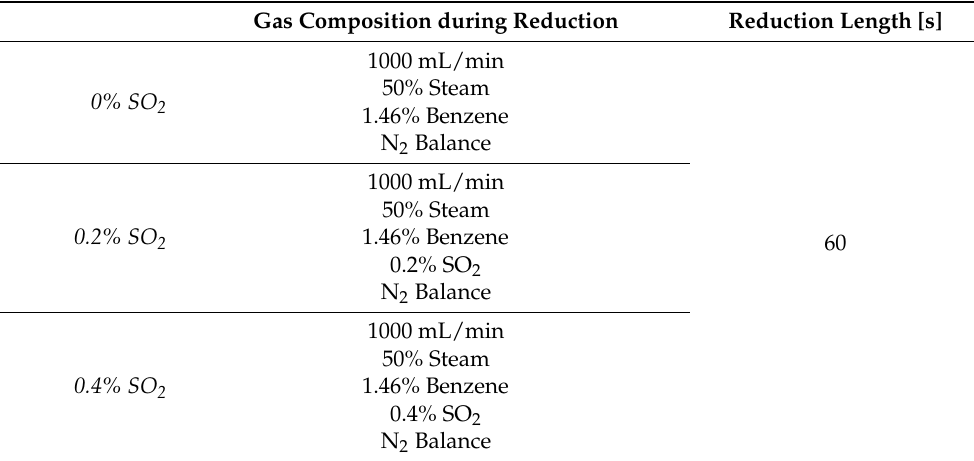
Table 4. Summary of gaseous fuel experiments containing